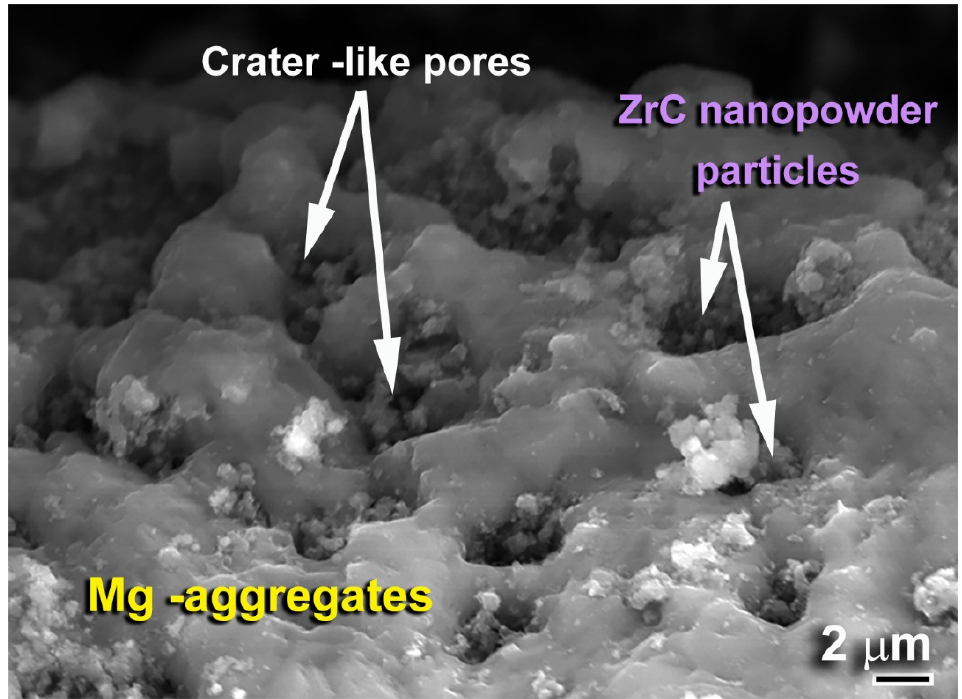
Figure 15. FE-SEM micrograph of MgH 2 /5 wt.% ZrC binary system, obtained after achieving 1400 h of cycle lifetime at 225 °C under uptake and hydrogen pressures of 10 and 0.4 bar, respectively (see Figure 14c).